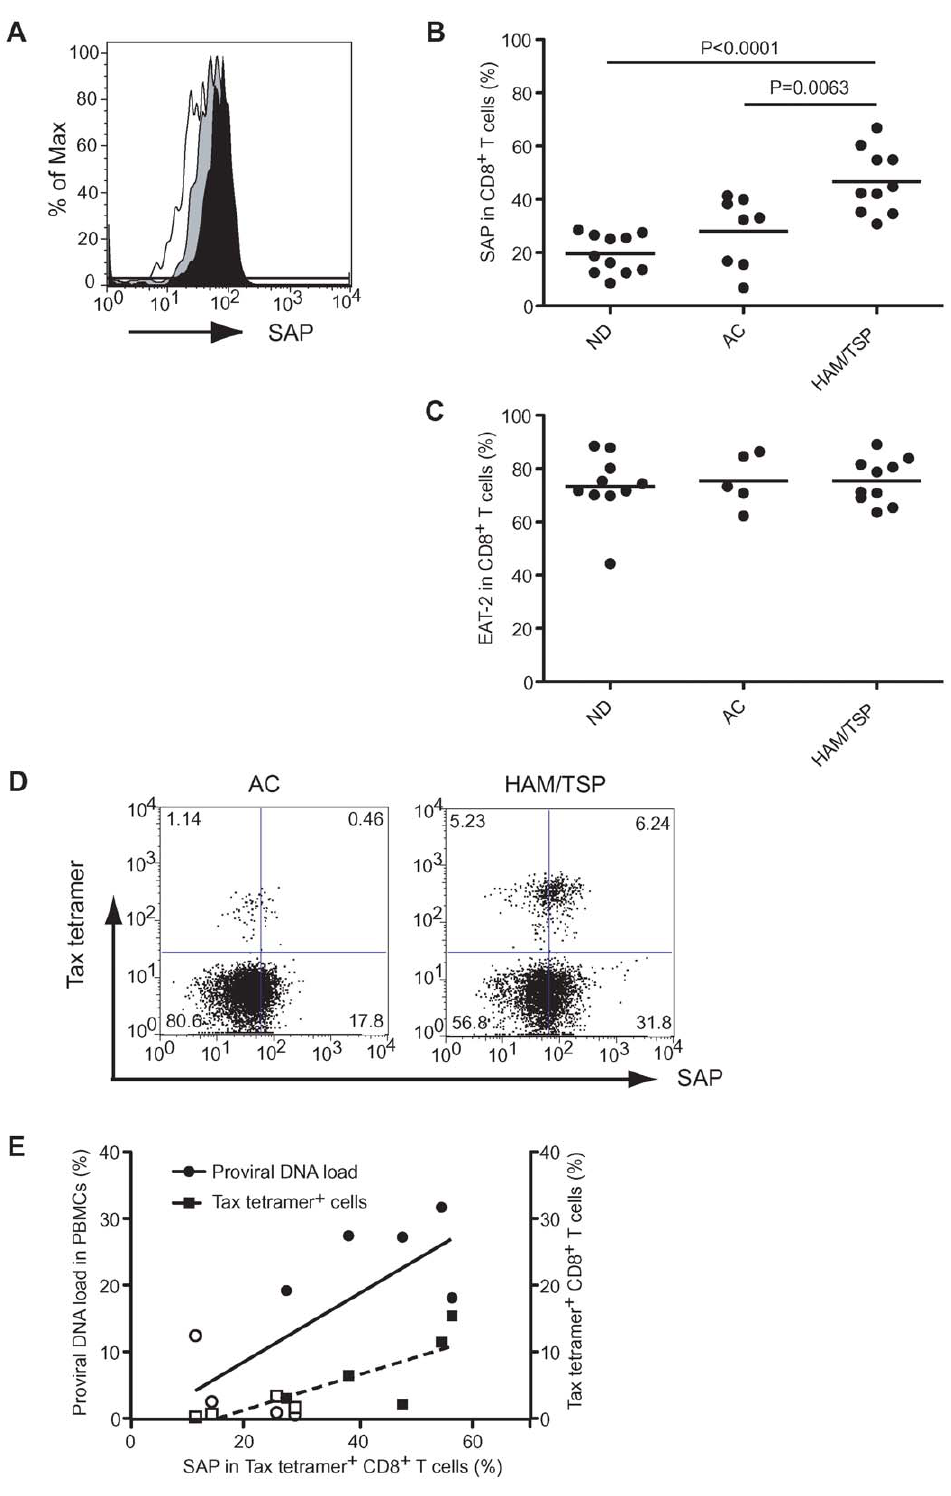
Figure 4. Expression of SLAM-associated proteins in CD8 + T cells of HTLV-I-infected patients. (A) Representative histograms of SAP expression in CD8 + T cells of a ND (opened histogram), an AC (grayed histogram), and a patient with HAM/TSP (closed histogram). (B) Comparison of SAP expression in CD8 + T cells of NDs (n=11), ACs (n=8) and patients with HAM/TSP (n=10). The horizontal line represents the median. (C) Comparison of EAT-2 expression in CD8 + T cells of NDs (n=10), ACs (n=5) and patients with HAM/TSP (n=10). (D) SAP expression in Tax11-19- specific CTLs of HTLV-I-infected patients. SAP expressions were shown in Tax11-19-specific CD8 + T cells of AC and patient with HAM/TSP. (E) Correlation of the HTLV-I-proviral DNA loads (circles; R 2 =0.4746, P=0.0401) and the frequency of Tax11-19-specific CD8 + T cells (squares R 2 =0.6811, P=0.0062) with SAP expression in the cells of AC (n=4, opened circles and squares) and patients with HAM/TSP (n=5, closed circles and squares).